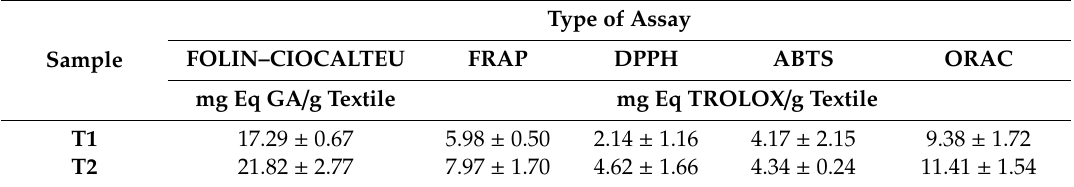
Summary of the Folin–Ciocalteu, FRAP, 2,2-diphenyl-1-picrylhydrazyl (DPPH), 2,2 (cid:48) -azinobis-(3-ethylbenzothiazoline-6-sulphonate) diammonium salts (ABTS), and ORAC values